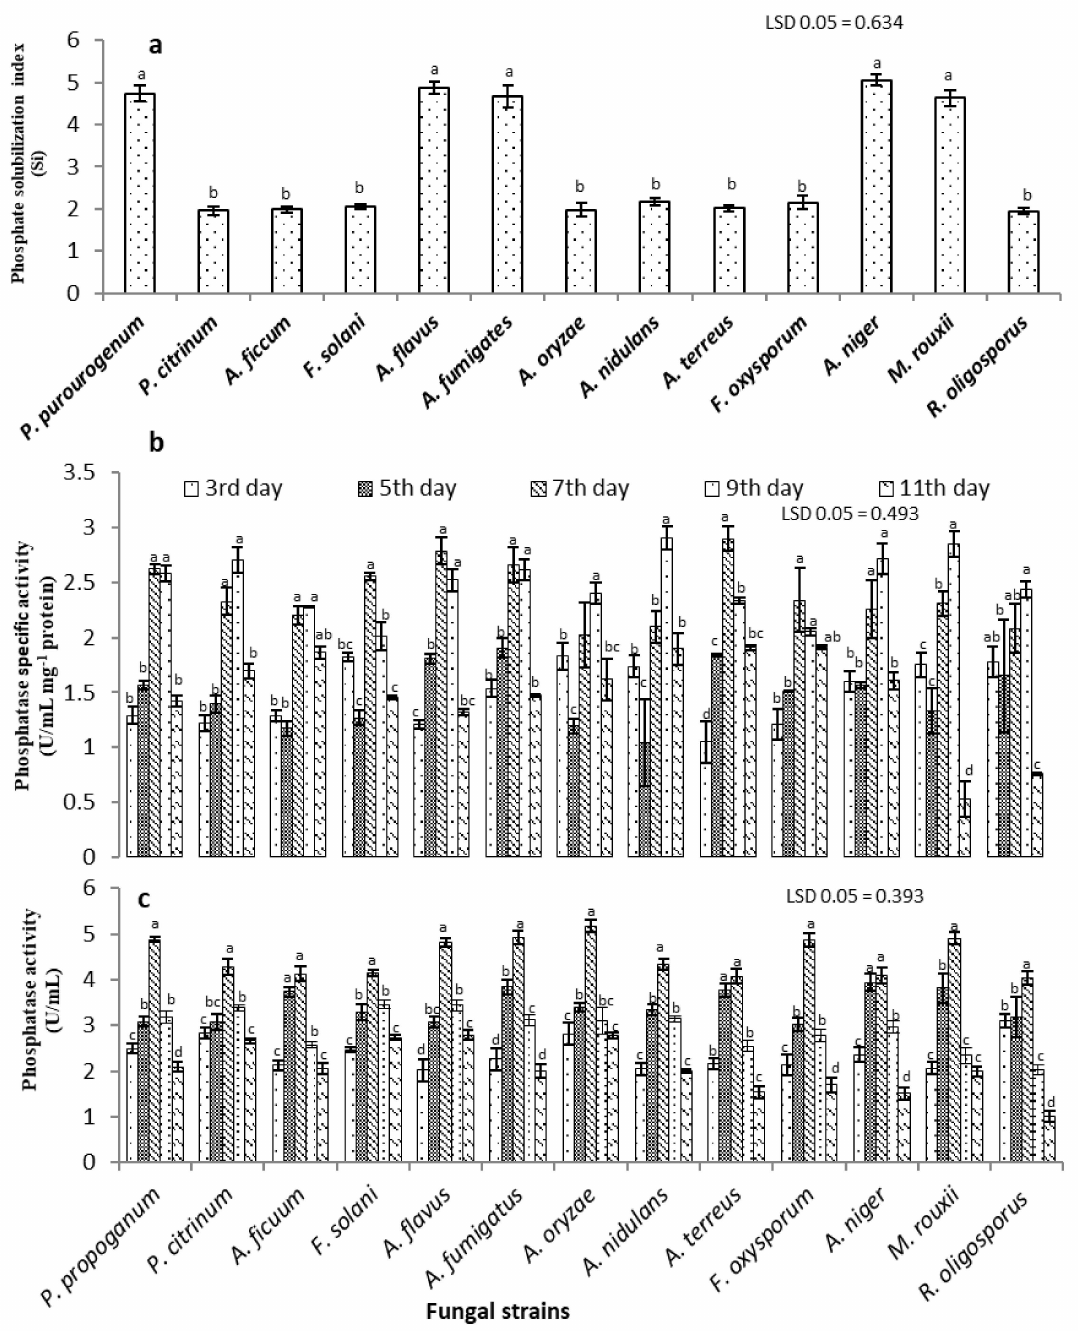
Figure 1. Screening of the 13 selected fungal strains for phosphate solubilizing index ( a ) calculated based on halo zone formation and comparison of phosphatase specific activities ( b ), phosphatase activities ( c ) at various time intervals (3–11 days). P. = Penicillium; A. = Aspergillus; F. = Fusarium, M. = Mucor; R. = Rhizopus. The given LSD value at 0.05 level refers to the significant differences among mean values of each